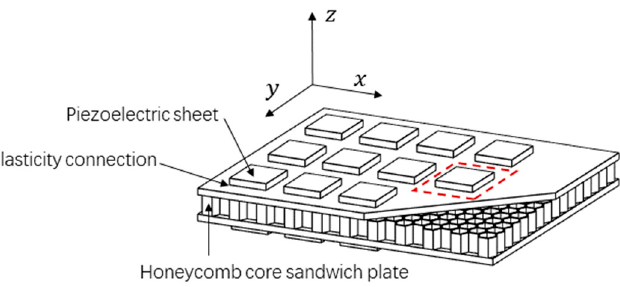
Figure 1. Three-dimensional structure of the metamaterial honeycomb core sandwich plate elas- tically connected with shunted piezoelectric patches.